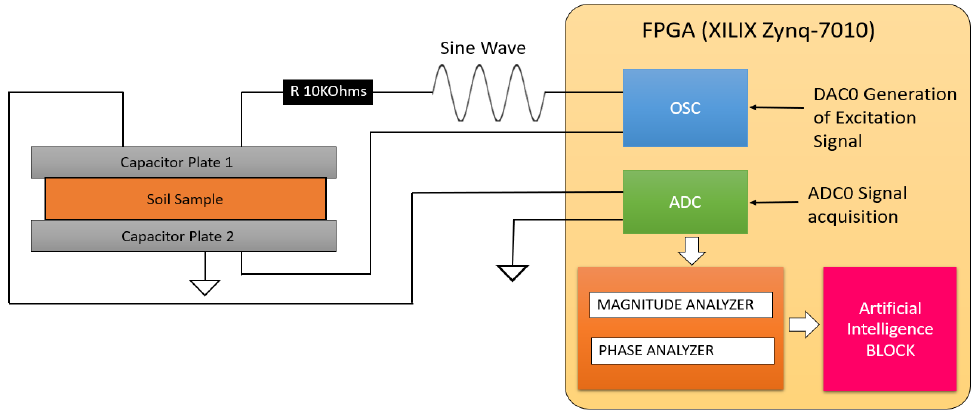
Figure 2. General diagram of the functioning of the capacitive sensor using the spectroscopy technique.